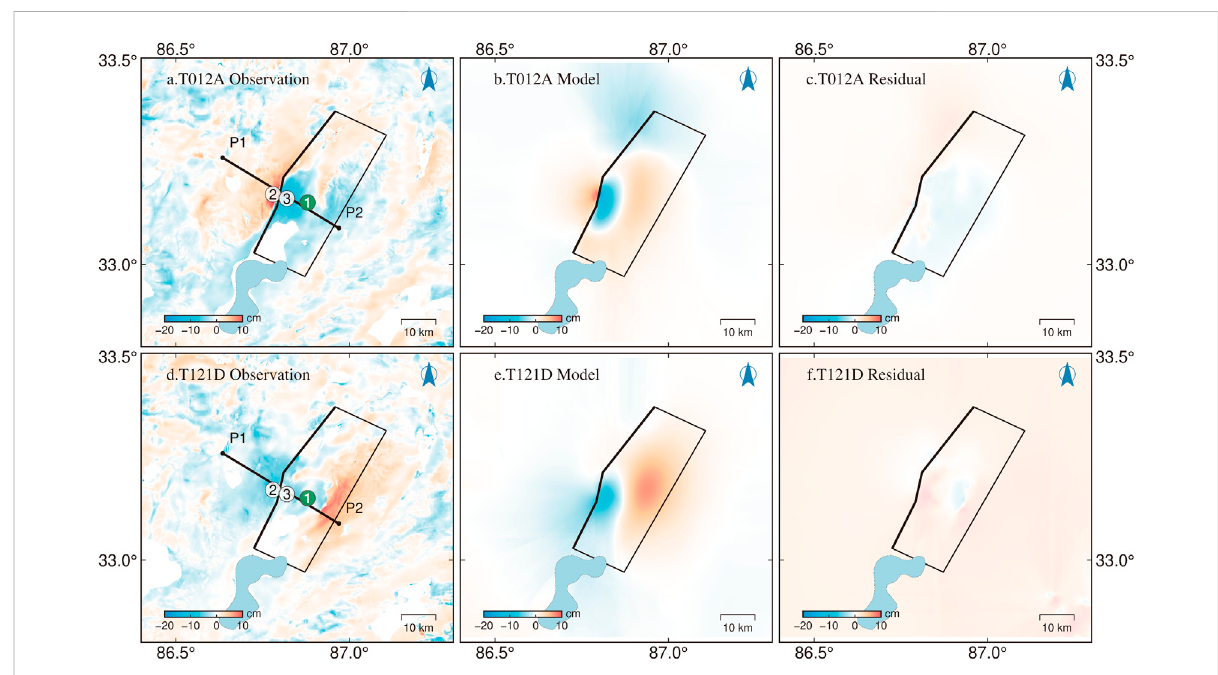
FIGURE 7 Postseismic deformation of the 2020 Nima earthquake inverted by the SDM method with residuals between the observations and simulated postseismc deformation by the model. Black box shows the surface projection of the rupture fault plane, which is derived from the optimal distributed slip model and thick black west side denotes the inferred seismogenic fault trace. The thick black line between P1 to P2 indicates the pro fi le be addressed in Figure 8. The circles marked with 1, 2 and 3 indicate sample points in Supplementary Figure S8.